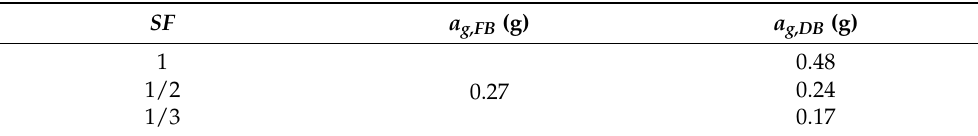
the force-based and displacement-based